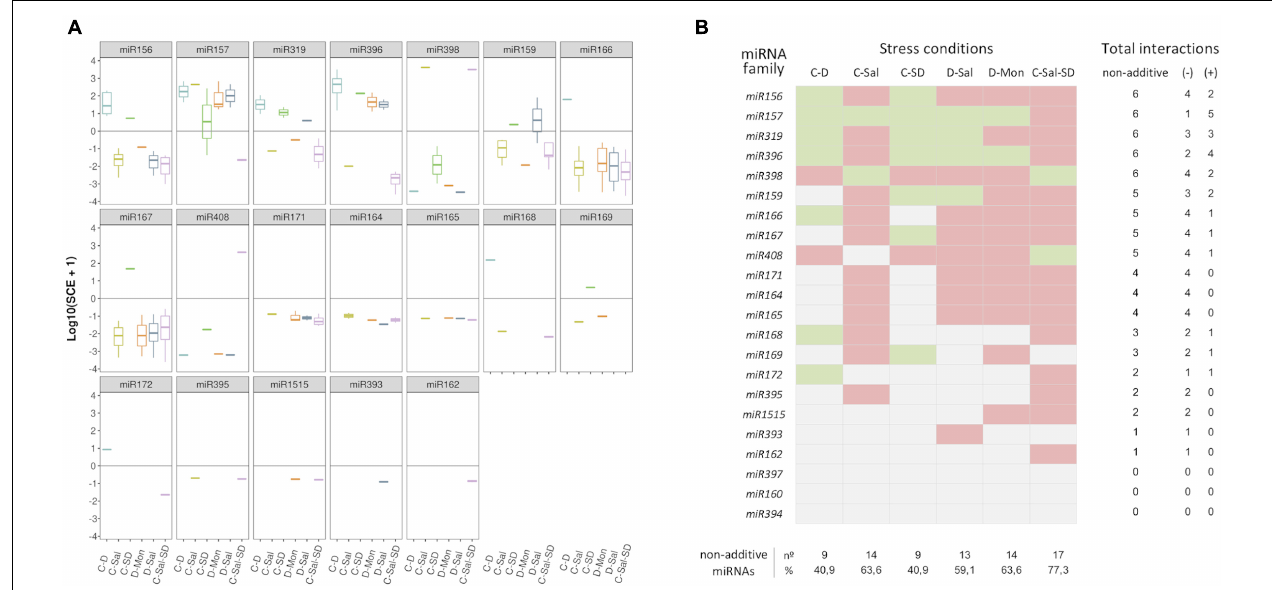
FIGURE 4 | Members of each miRNA family respond in a coordinated manner to combined stresses. (A) Boxplot analysis showing the SCE values for family-miRNA-related members in each combined stress condition. To determine the general sense of the effect induced by combined stresses for each miRNA family, we employed the median of the SCE values obtained for the totality of the family members (represented by the internal box line). (B) Graphic representation of the global non-additive positive (green) or negative (red) effects associated with combined stresses estimated for each miRNA family in the six stress conditions analyzed here. The number of combined stresses that induce positive and/or negative non-additive responses in each miRNA family is detailed in the right columns. The proportion of miRNA families with non-additive effects in response to each combined stresses is detailed below.